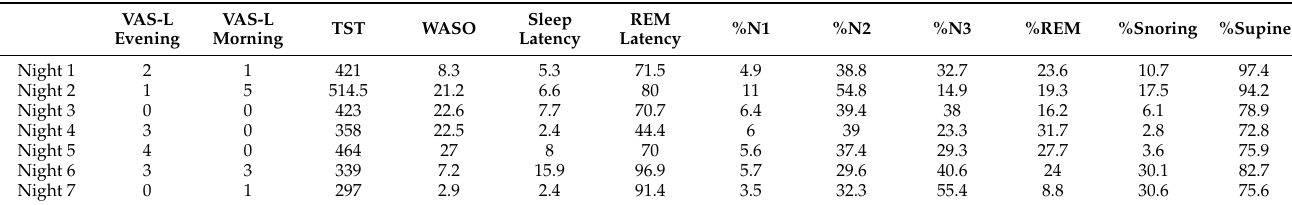
Table A1. Longitudinal sleep characteristics.